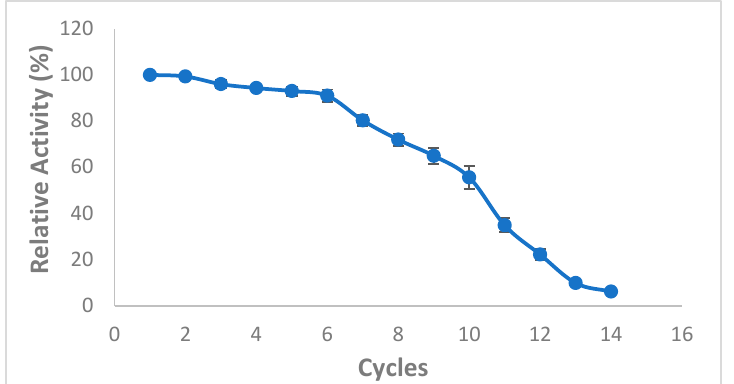
Figure 7. Effect of mixed CaCO 3 -immobilized-lipases reuse on the transesterification of waste cooking oil (WCO) for biodiesel synthesis. The following experimental conditions were used: methanol/oil molar ratio: 6:1, lipase loading 1%, water content 5%, reaction temperature 55 °C, reaction time 24 h, agitation speed 200 rpm. 100% is the biodiesel yield of the first reaction, while the successive reaction yields were calculated accordingly. Experiments were performed in triplicate and error bars indicate mean ± standard deviation.